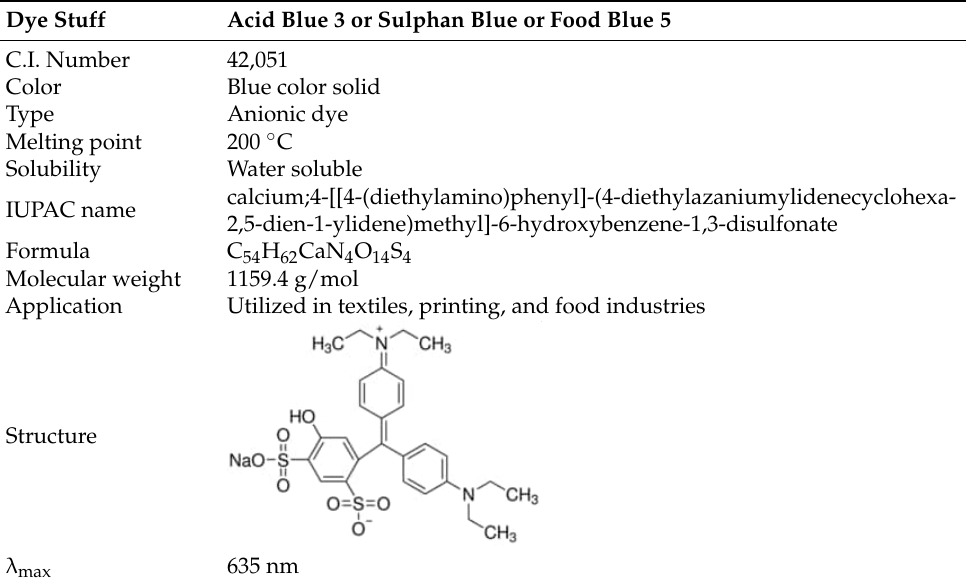
Table 1. Features of Patent